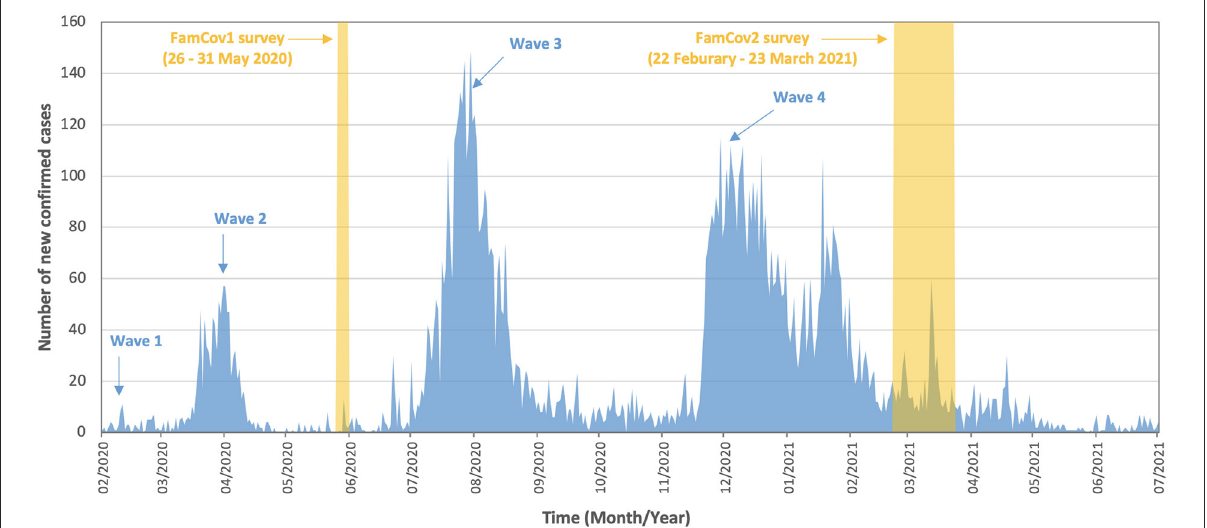
FIGURE1 Number of new confirmed cases of COVID-19 from February 2020 to July 2021 in Hong Kong. The highlighted periods show the time period during which data of FamCov1 and FamCov2 surveys were collected. Wave 5 started in Jan 2022 with a peak of 56,827 cases (almost all Omicron BA.2) on 3 March 2022, and reduced to 234 cases on 16 May